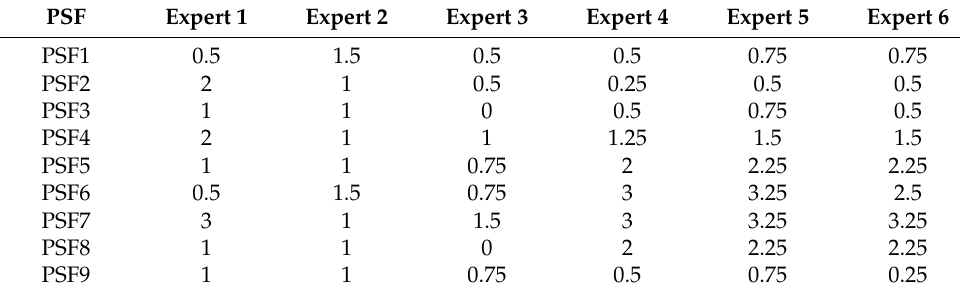
Table 8. The collected impact data of each PSF concerning ST 1.1.